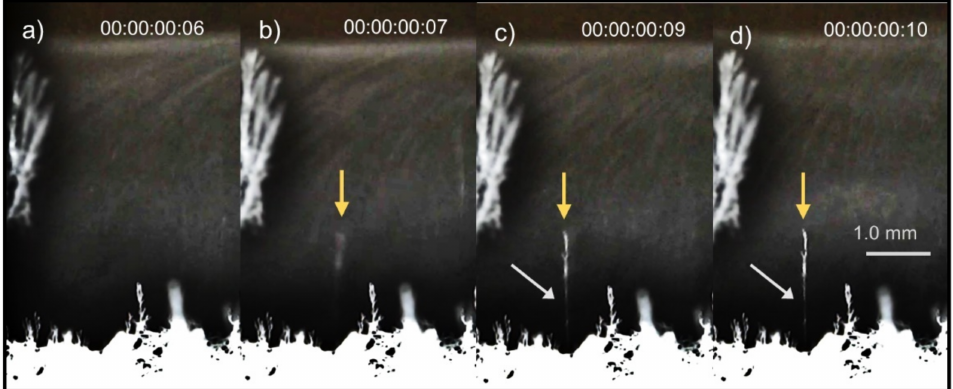
Figure 4. Consecutive contrast/brightness enhanced frames show the same area, where a floating ice needle (yellow arrows) appears in the lower part of each frame. There is no sign of a needle in frame ( a ) but it appears faintly in the following frame, Note the increase in needle contrast and its thickening, from ( b – d ) in the bottom, whereas its length remains nearly constant. The needle is not uniform along its length. Grey arrows point to a needle extension towards the lower surface, appearing only in the two frames to the